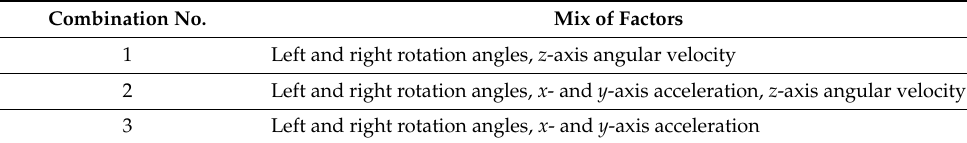
Table 3. Training input factor combinations.